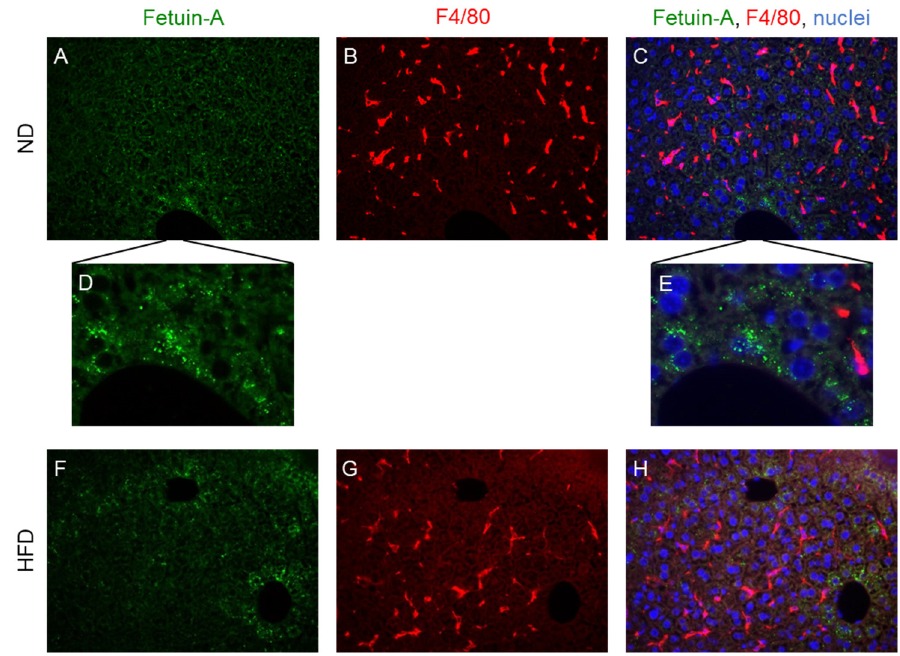
Figure 2. Fetuin-A distribution in the liver. Representative immunofluorescence detection of fetuin- A (green) ( A , C , D – F , H ), F4/80 positive cells (red) ( B , C , E , G , H ) and nuclei (blue) ( C , E , F ) in liver sections of a normal diet (ND)-fed animal ( A – E ) and a high-fat diet (HFD)-fed animal ( F – H ). The magnification ( D , E ) allows the visualization of the granular aspect of fetuin-A within the hepatocytes.